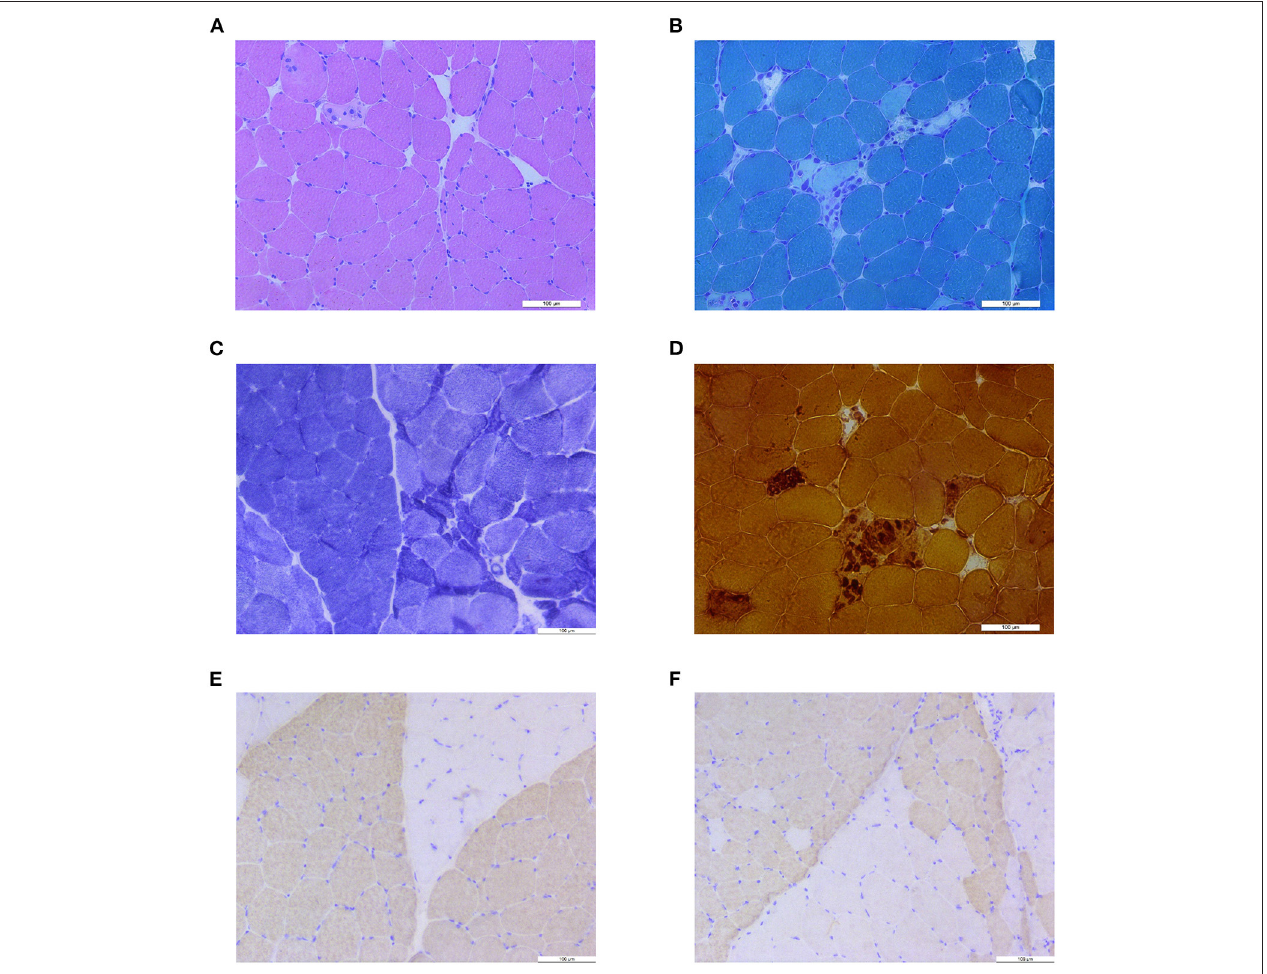
FIGURE 1 | Muscle biopsy results. (A) H&E stain showed isolated necrotic muscle fiber and atrophic muscle fibers. (B) Modified Gomori trichrome (MGT) stain showed small cluster of necrosis and macrophage of muscle fibers. (C) Nicotinamide adenine dinucleotide tetrazolium oxidoreductase (NADH-TR) stain revealed grouping of myofibers and a small group of atrophic fibers. (D) Nonspecific esterase (NSE) staining showed necrosis and phagocytosis of muscle fibers. (E) Anti-fast-myosin immunohistochemistry (IHC) stain showed grouping of type 1 (pale) and type 2 (dark) myofibers. (F) Anti-slow-myosin IHC stain showed grouping of type 1 (dark) and type 2 (pale)